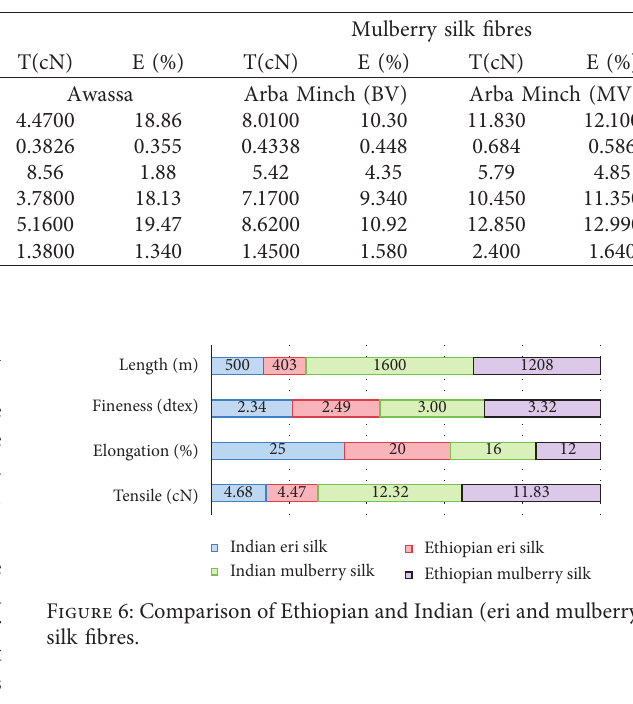
Table 3: Statistical descriptions of tensile strength and elongation of eri and mulberry silk.